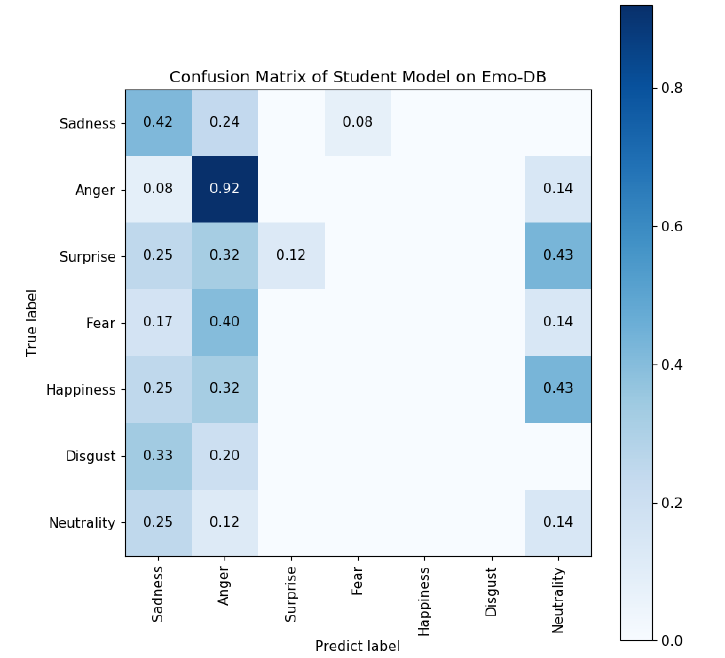
Figure 12. Confusion matrix of our student model on